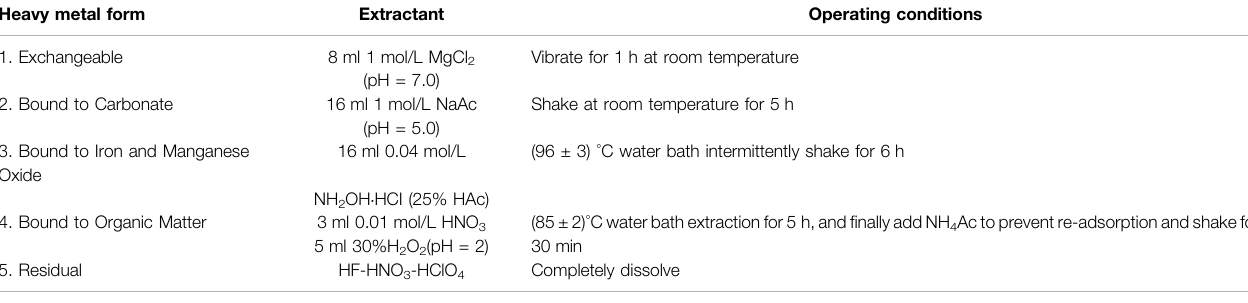
TABLE 1 | Tessier continuous extraction method. Heavy metal form